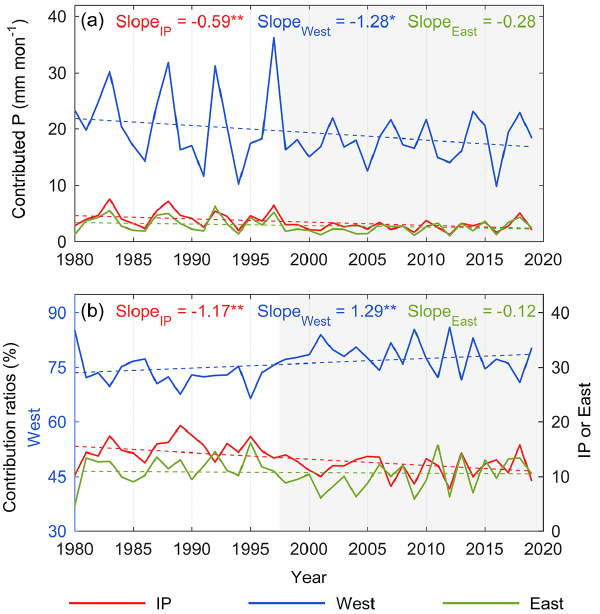
Figure 6. Variations of (a) contributed precipitation (unit of the slope: mm per month per decade) and (b) contribution ratios (unit of the slope: % per decade) from the IP, the west and the east regions during 1980–2019 summer. ** and * represent 0.05 and 0.1 signifi- cance levels of the trend.